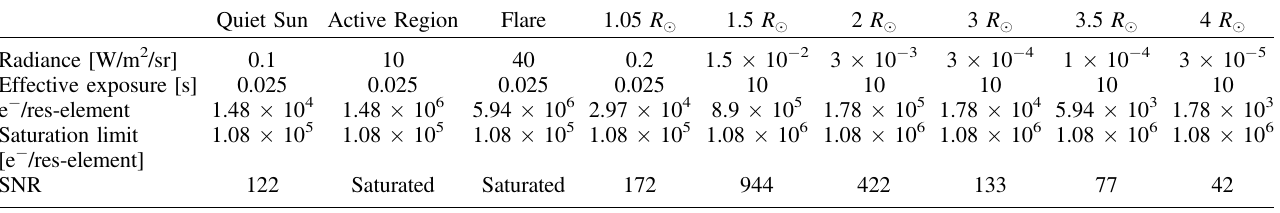
Table 2. SunCET SNRs for on-disk features and CME loops above the limb. Radiances are from GOES/SUVI 195 Å images of the 2017-09-10 CME (Seaton & Darnel, 2018) and are extrapolated beyond its FOV of 1.7 R (cid:1) . SNR at all heights is above the level that ISO 12232 de fi nes as “ excellent ” .